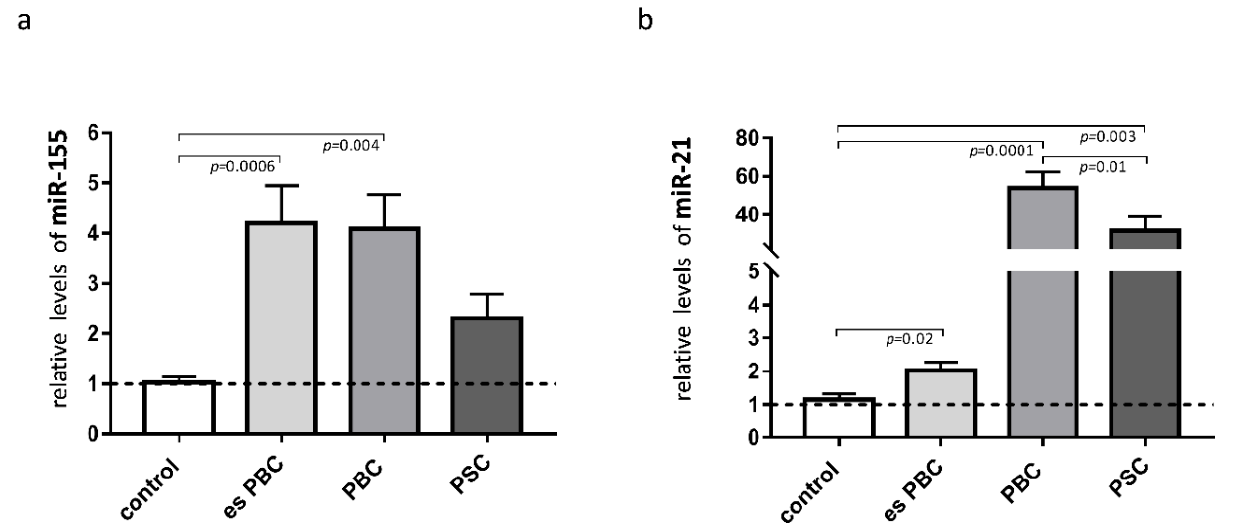
Figure 2. Expression of miR-155 and miR-21 in liver tissue. In patients with primary biliary cholangitis (PBC), both miR-155 ( a ) and miR-21 ( b ) expression were increased in comparison to the healthy controls. In livers of PSC patients, only miR-21 was substantially induced. MiR-16 served as the reference for loading. Bars indicate the mean ± SEM. Statistical analysis was performed using ANOVA or a Student’s t -test.